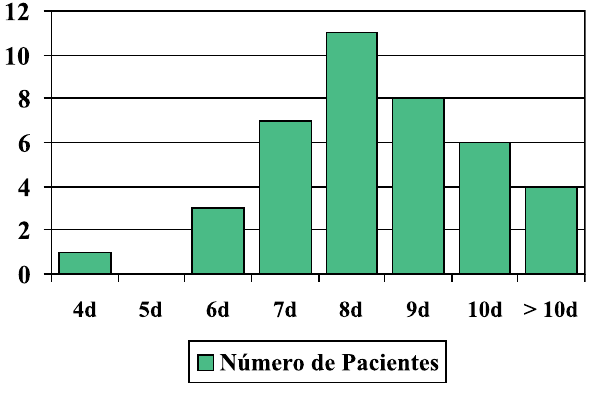
Fig. 3 - Permanência hospitalar em dias dos pacientes acima de 75 anos operados sem CEC e sem